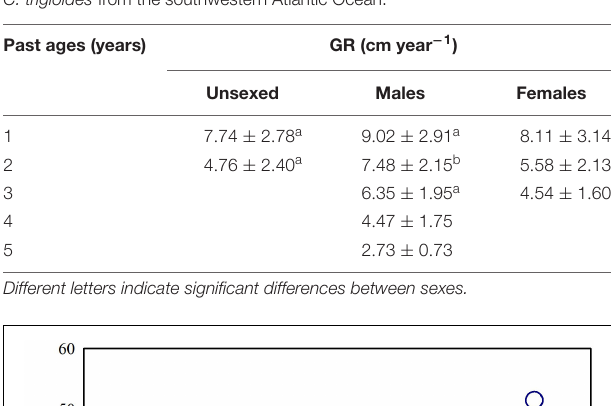
H = 10.094, p = 0.006) and Mn:Ca ratios were found (Kruskal– Wallis, H = 21.407, p = 0.001). Fish from BB showed lower values as compared to NPS and SPS (Dunn’s tests, p <